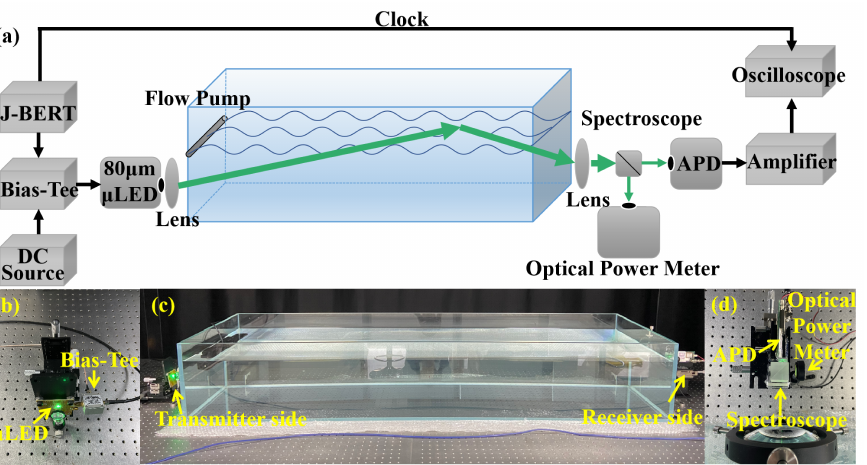
Figure 4. Experiment setup of the proposed UWOC system based on an 80 µ m × 80 µ m InGaN-based Micro-LED: ( a ) schematic diagram, ( b ) transmitter side, ( c ) image of the proposed UWOC system based on a 80 µ m × 80 µ m InGaN-based MFicro-LED, ( d ) receiver